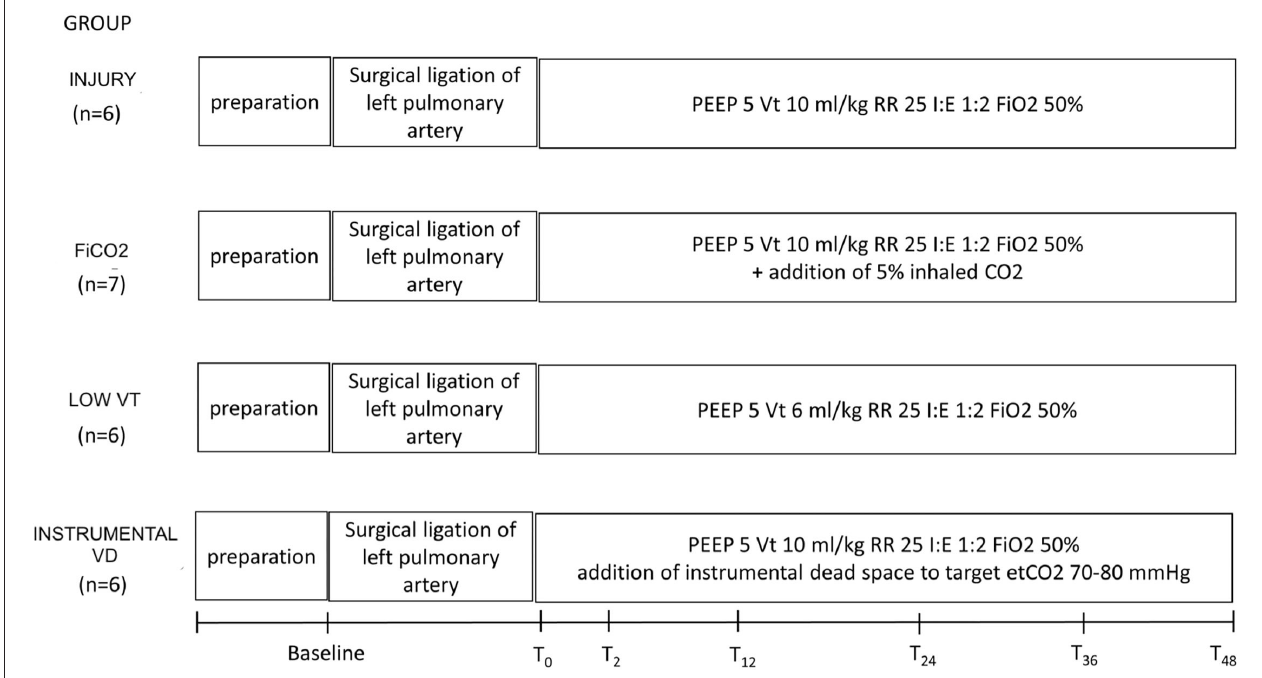
FIGURE 1 | Study design and timeline. Preparation corresponds to anesthesia and invasive monitoring, which took about 1h. After baseline measurements, animals underwent surgical ligation of the left pulmonary artery. T0 to 48 corresponds to the study period, during which each group received a specific treatment, according to the study group. VT, tidal volume; PEEP, positive end-expiratory pressure in cm H 2 O; RR, respiratory rate in